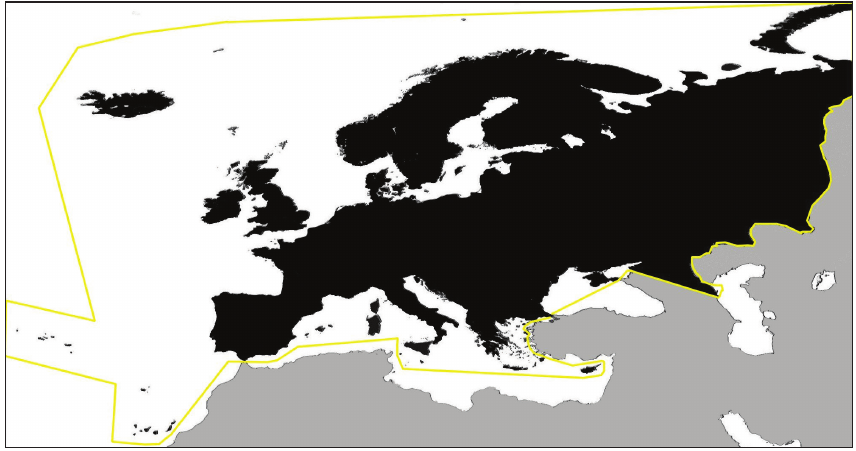
Figure 1. Conventional boundaries of the geographical area where ChiloKey is